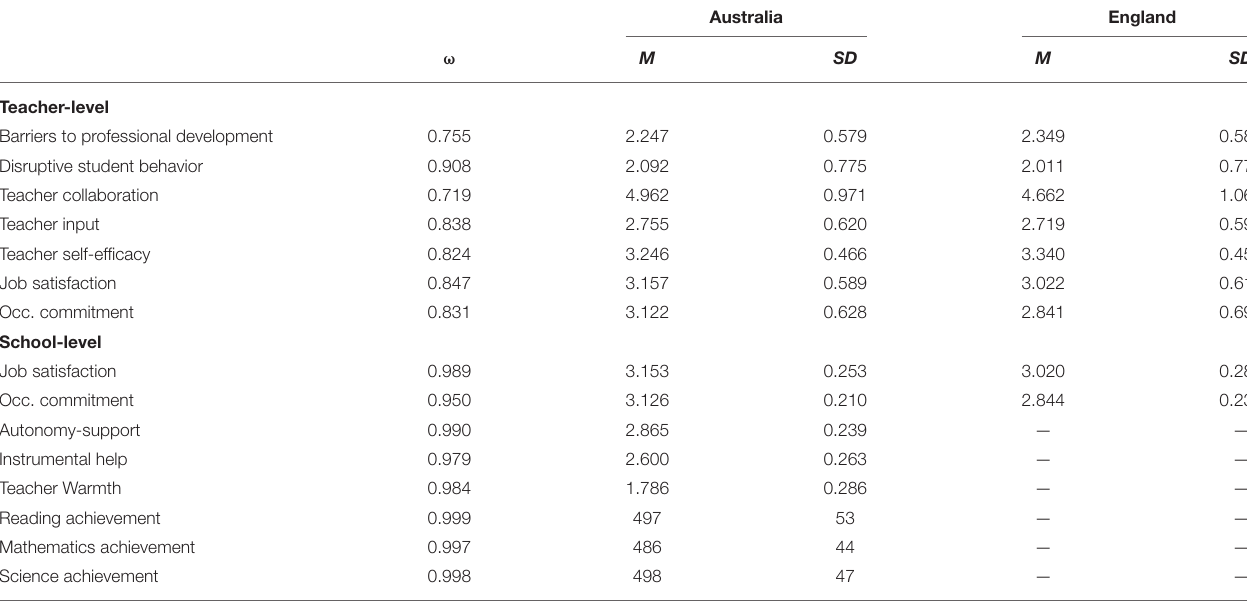
TABLE 1 | Reliabilities and descriptive statistics for both